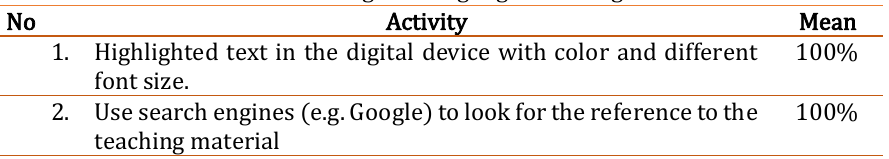
Table 2. Observation Table of Augmentation ICTs Used by the